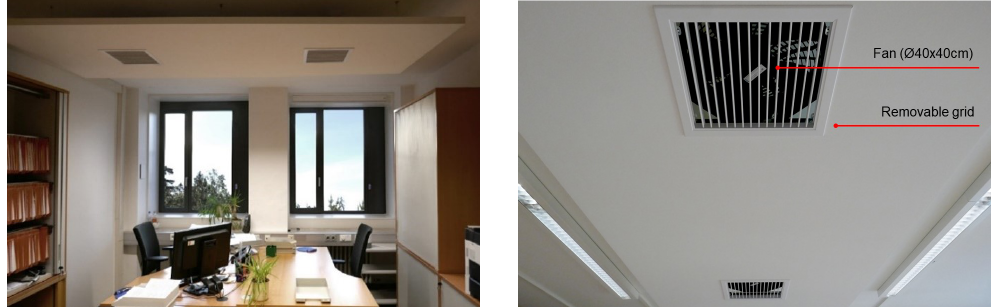
Figure 2. Example of an office room, showing the new window system ( left ) and integrated personal ceiling fan in an acoustic panel with a removable grid to adjust the airflow direction ( right ). Copyright (left image): 2021, Bergische Universität Wuppertal.